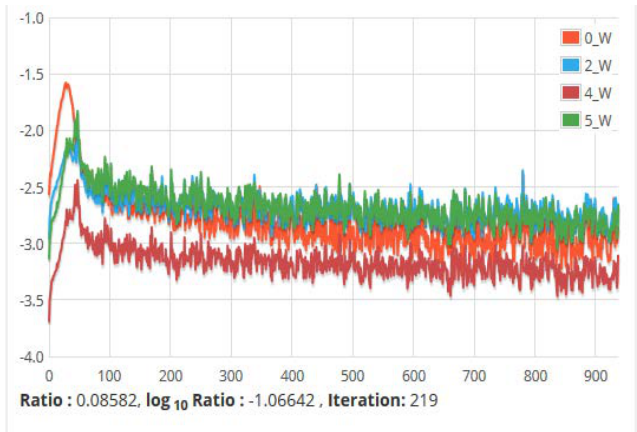
Figure 18. The ratio of parameters to updates (by layer) for all network weights vs. Iteration. It shows the update of the parameters against the number of iterations taken during training.